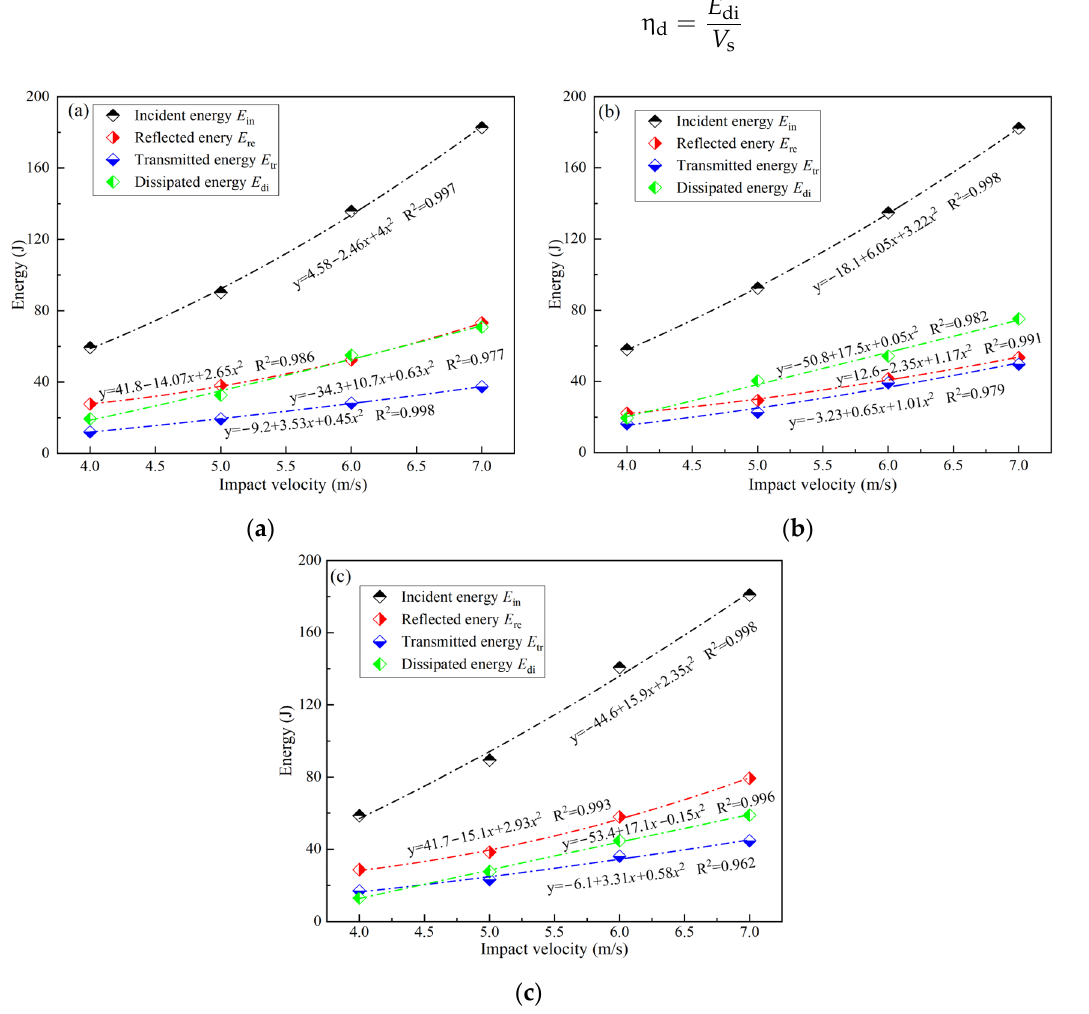
Figure 15. Evolution of rock energy distribution with saturation of ( a ) S r = 0%, ( b ) S r = 50%, and ( c ) S r = 100%.